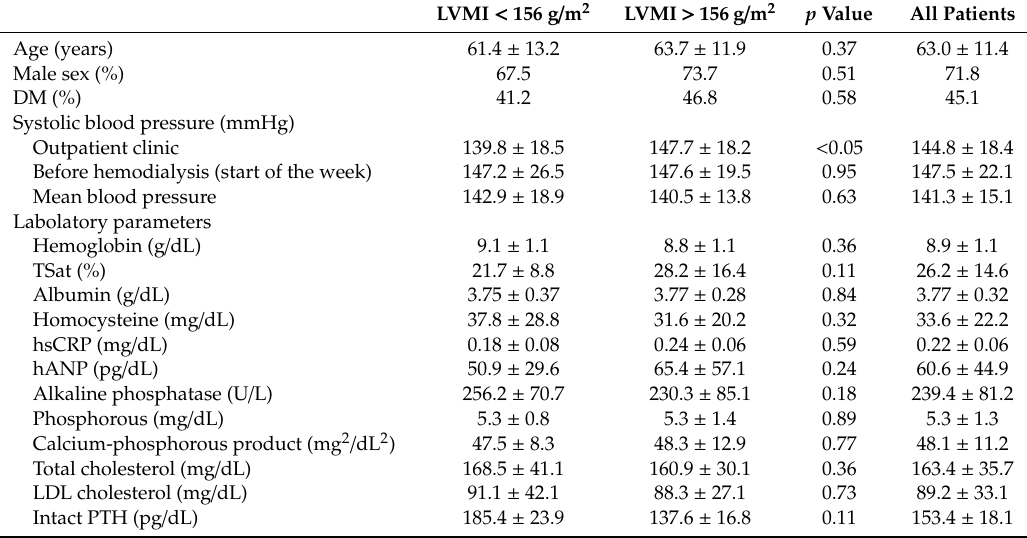
Table 3. Comparison of baseline characteristics between patients with LVMI < 156 g / m 2 and patients with LVMI > 156 g / m 2